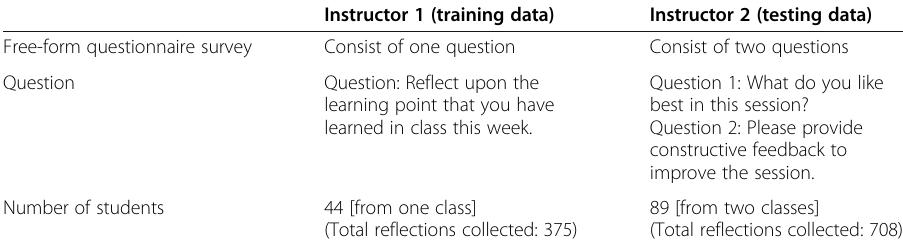
Table 1 Details of reflection data collected Instructor 1 (training data) Instructor 2 (testing data) Free-form questionnaire